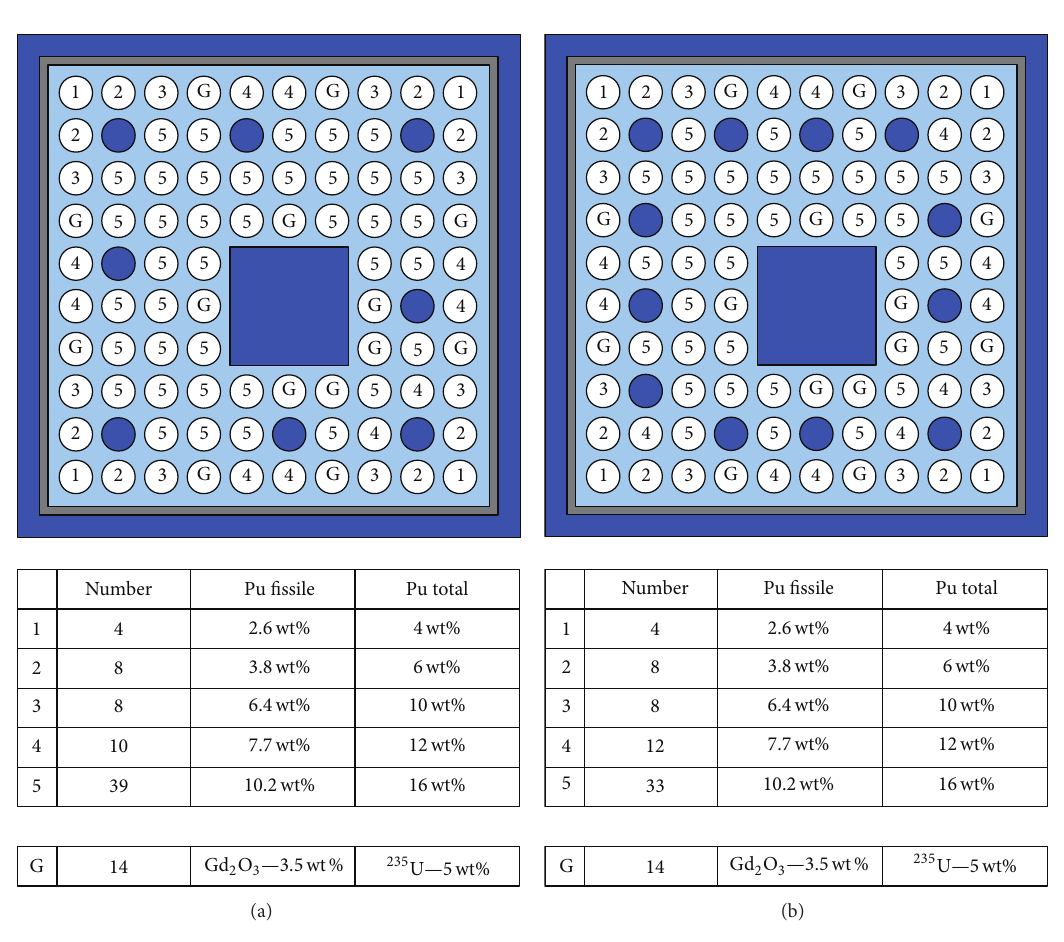
Figure 3: Modified BWR assemblies designs with 8 (a) and 12 (b) water holes. Table 1: Innovative BWR fuel assemblies’ specifications.